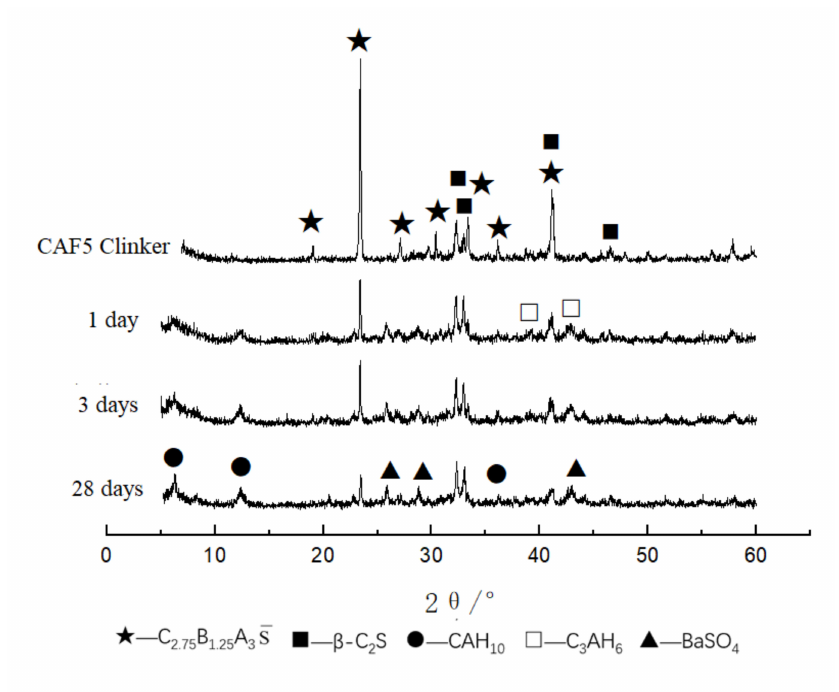
Figure 8. XRD patterns of CAF5 at different curing